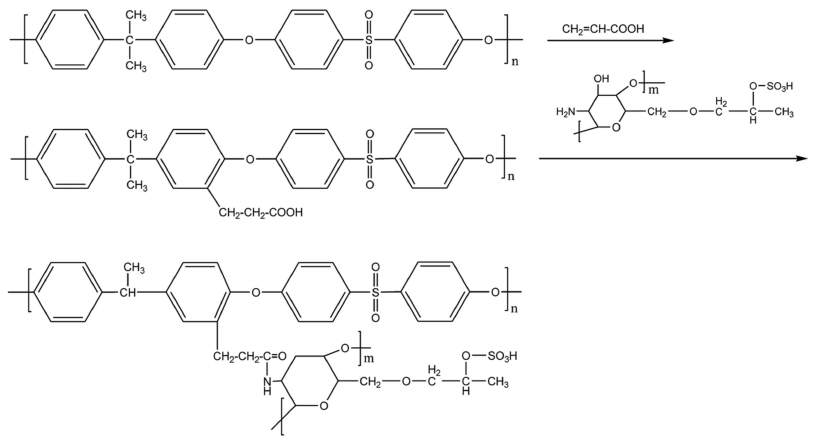
Figure 3. The steps of the modification of the PSF membrane (reproduced with permission after [64]).